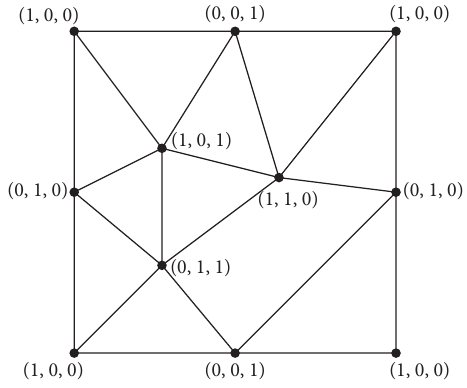
Figure 1: Toroidal embedding of AG ′ ( Z